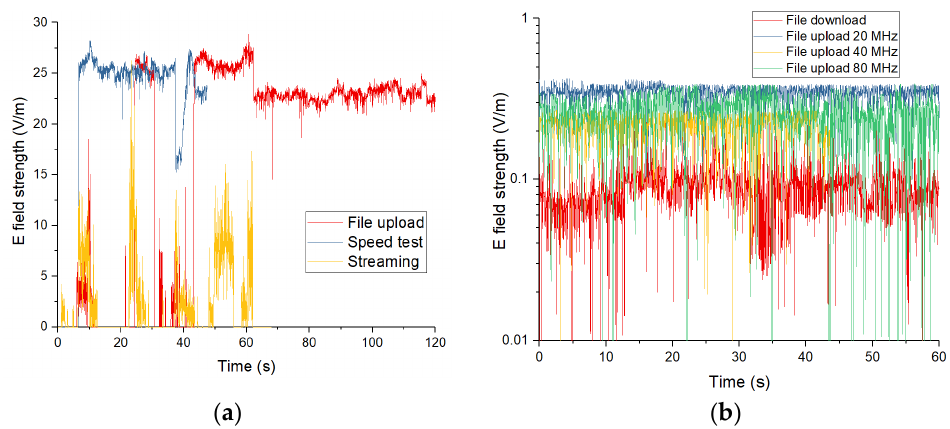
Figure 15. Time evolution of Efor LTE-A ( a ) and 802.11ax ( b ) experimental scenarios.